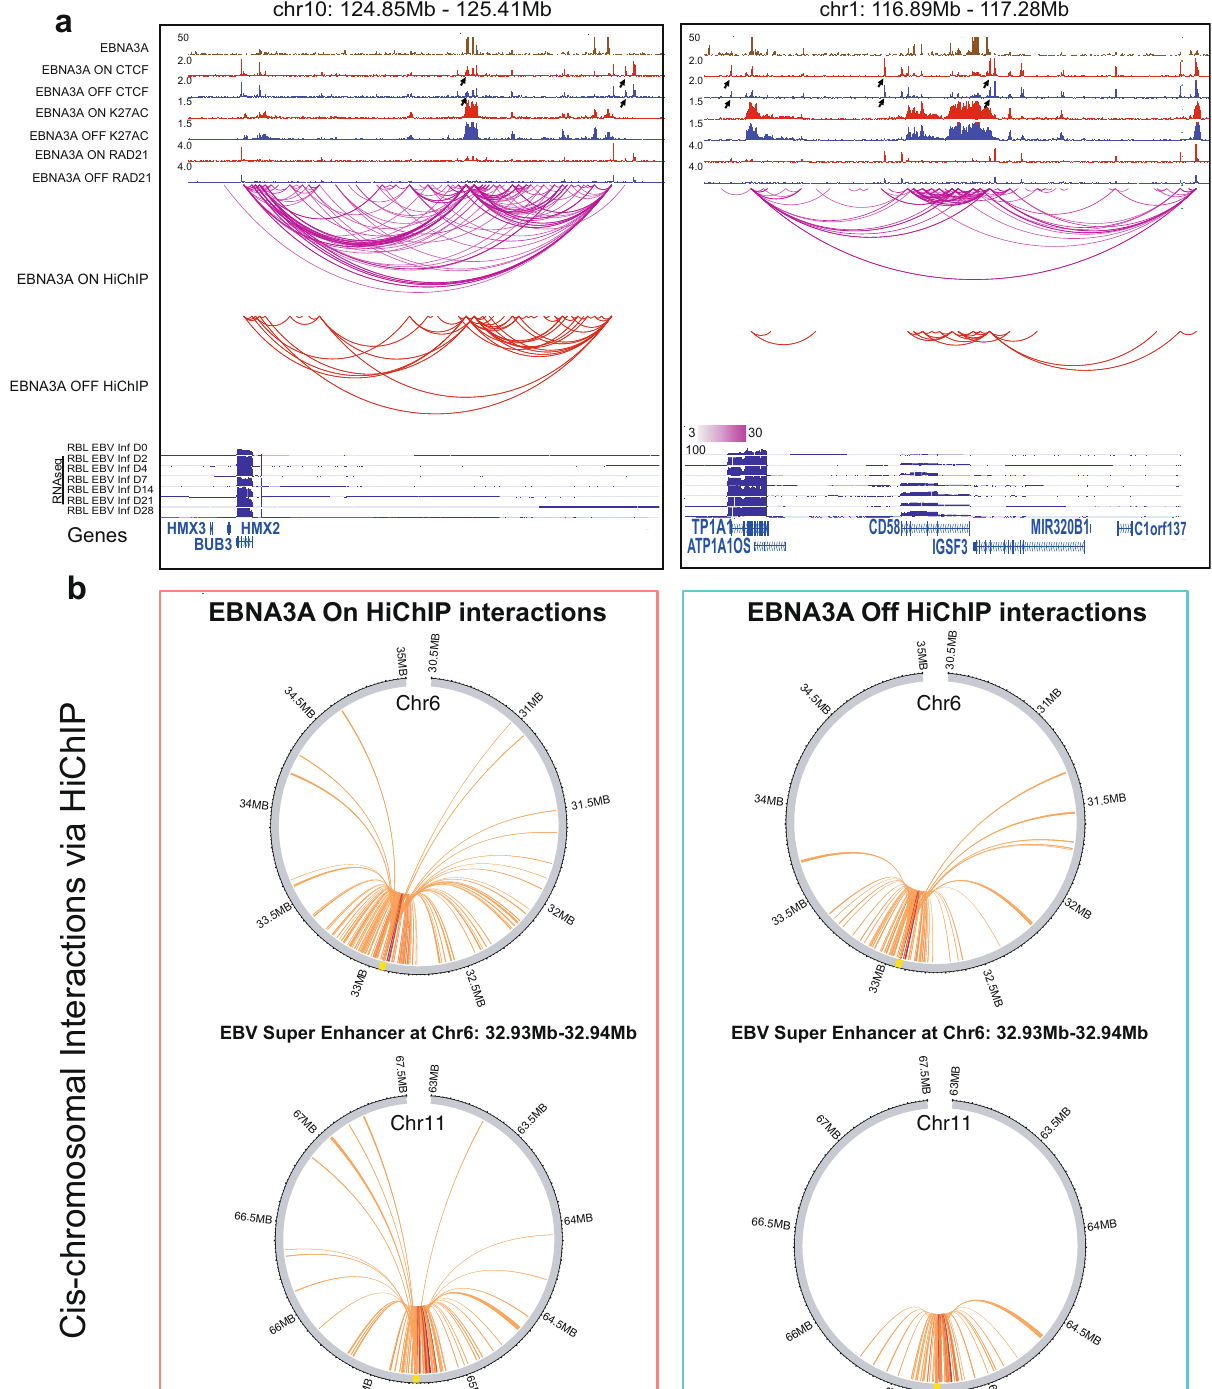
Fig. 6 | EBNA3A inactivation reduces ESEs loopings. a Inactivation of EBNA3A resulted in signi fi cantly less interactions between ESEs at chromosome 10 (BUB3, left) and chromosome 1 (ATP1A1 and CD58, right) and their direct target genes. HiChIP links with fi lter threshold >3 are shown. Black arrows indicate different